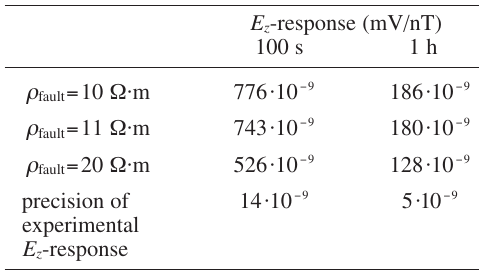
experimental E z